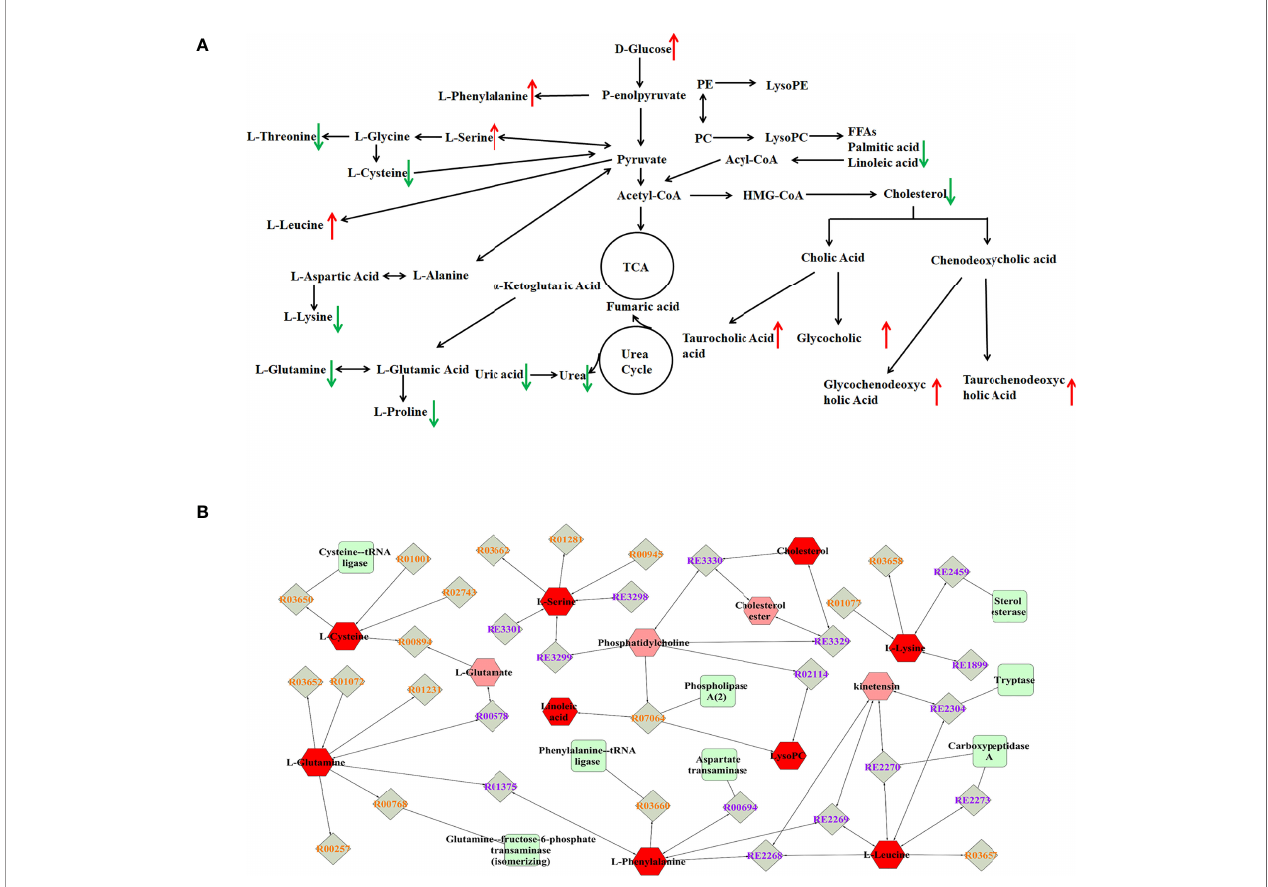
FIGURE 3 | Analysis of potential biomarkers and related pathways. (A) Schematic overview of metabolic pathways based on the differentially expressed metabolites. The metabolites indicated with red or green arrows represent increased or decreased levels, respectively, in PTDM group. (B) The compound-reaction-enzyme-gene subnetwork. Red hexagons represent the identi fi ed differentially expressed metabolites. Green squares represent enzymes which might regulate the identi fi ed metabolites. Grey diamonds represent reactions catalyzed by those